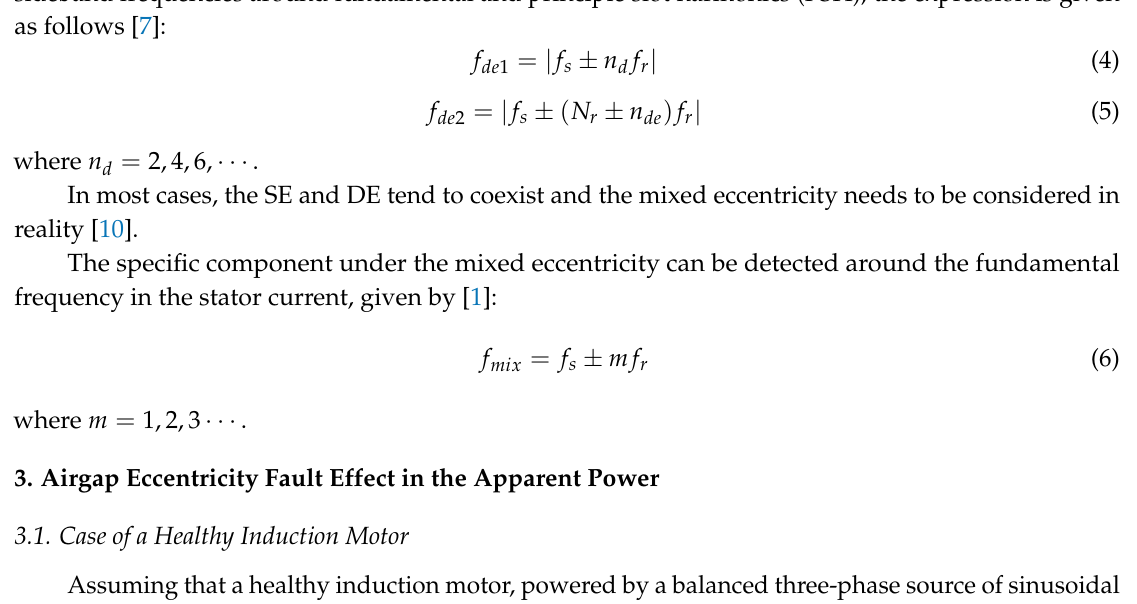
Figure 3. Schematic model of a motor rotational under dynamic eccentricity.